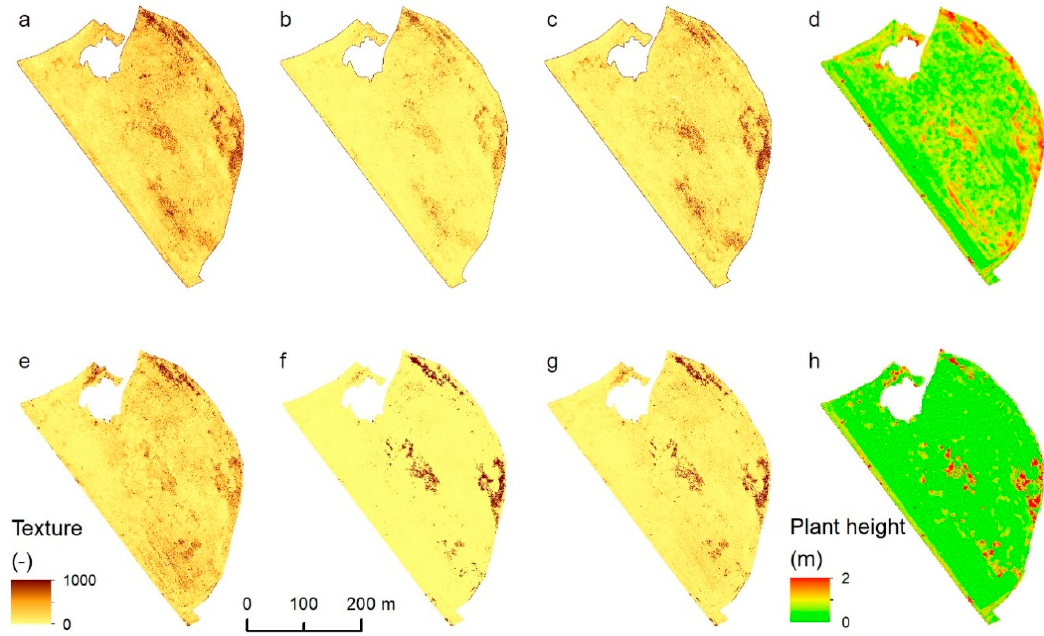
Figure 4. Surface elevation information of 2015 ( a – d ) and 2016 ( e – h ) imagery in forms of texture from green ( a , e ), red ( b , f ) and near-infrared bands ( c , g ), and plant height ( d , h ).